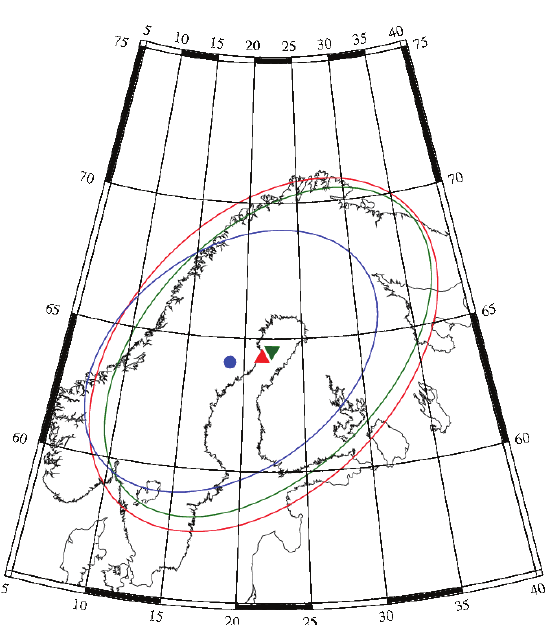
Fig. 4. The best-fit ellipses found for various modelling scenarios. Red triangle: the whole BIFROST area; green inverted triangle: BIFROST central area; blue circle: the Finnish precise levelling. Note significant difference between BIFROST on the one hand and the Finnish levelling on the other, suggesting that the land uplift geometry is in reality asymmetric